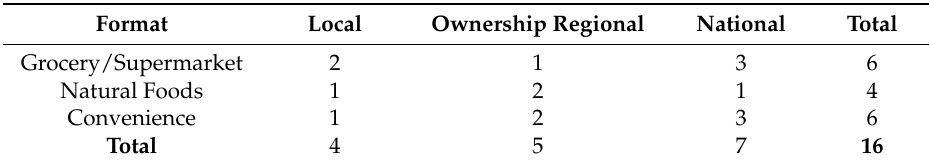
Table 2. Format and ownership of retailers in the case